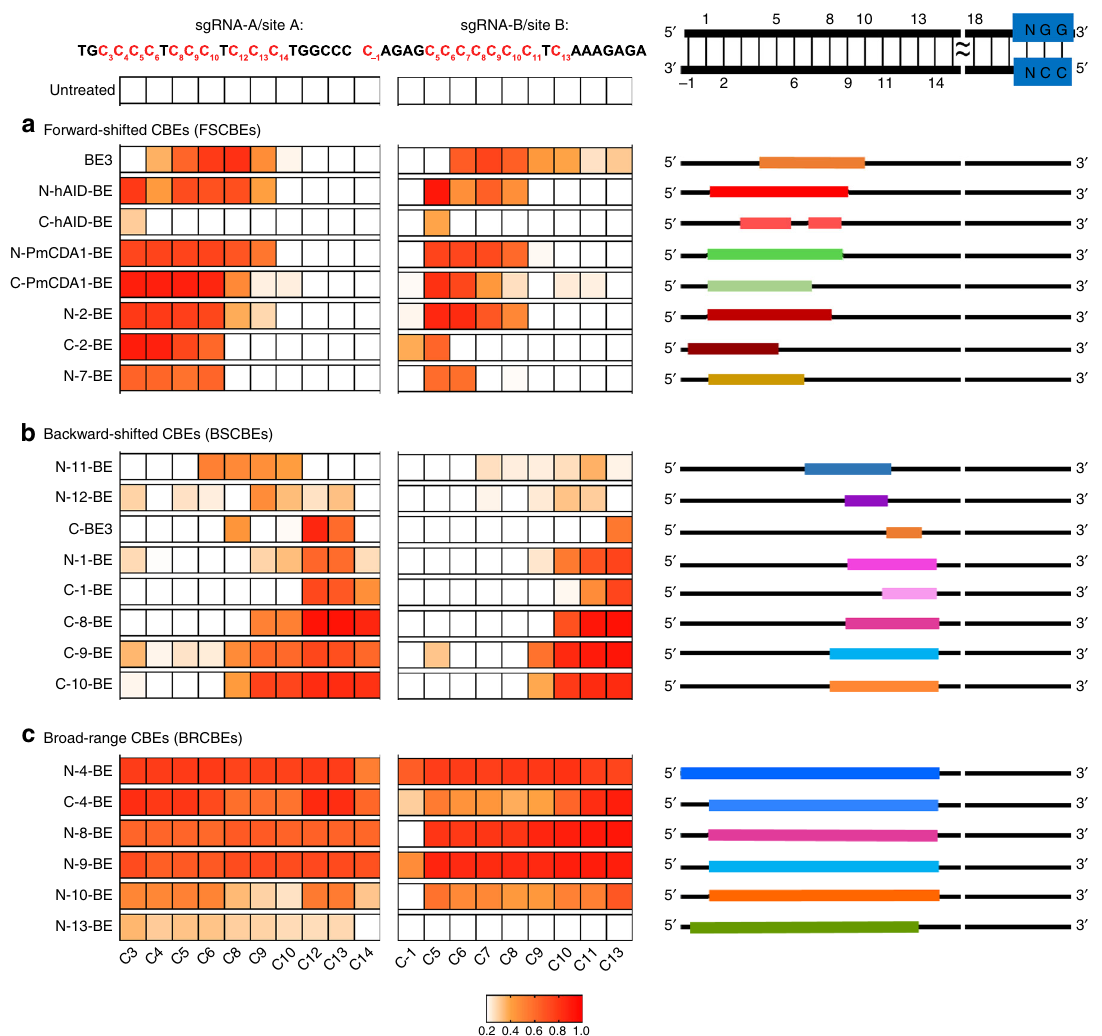
Fig. 4 Classi fi cations of CBEs depending on the editing scopes for sgRNA A/B/C/D. The editing scopes were preliminary de fi ned as C positions (CP) with ≥ 40% editing frequency at sgRNA A/B/C/D. a Forward-shifted CBEs (FSCBEs) mainly edit the forward region of target DNA. b Backward-shifted CBEs (BSCBEs) mainly edit the backward region of target DNA. c Broad-range CBEs (BRCBEs) could edit both forward and backward regions of target DNA. Editing signatures for sgRNA C/D were shown in Supplementary Fig. 3. Source data are provided as a Source Data fi